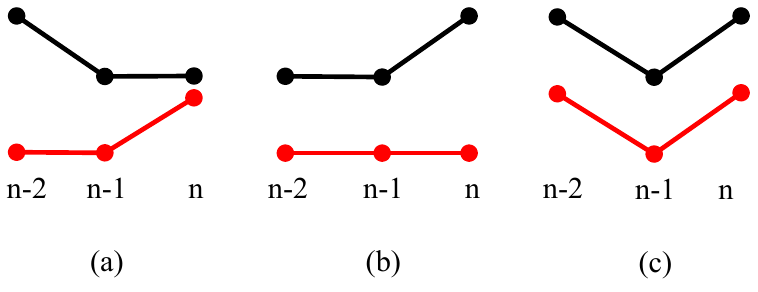
Figure 7. T ( n − 1) = 00 and T ( n ) ≠ 00. ( a ) T ( n ) = 01; ( b ) T ( n ) = 10; ( c ) T ( n ) =